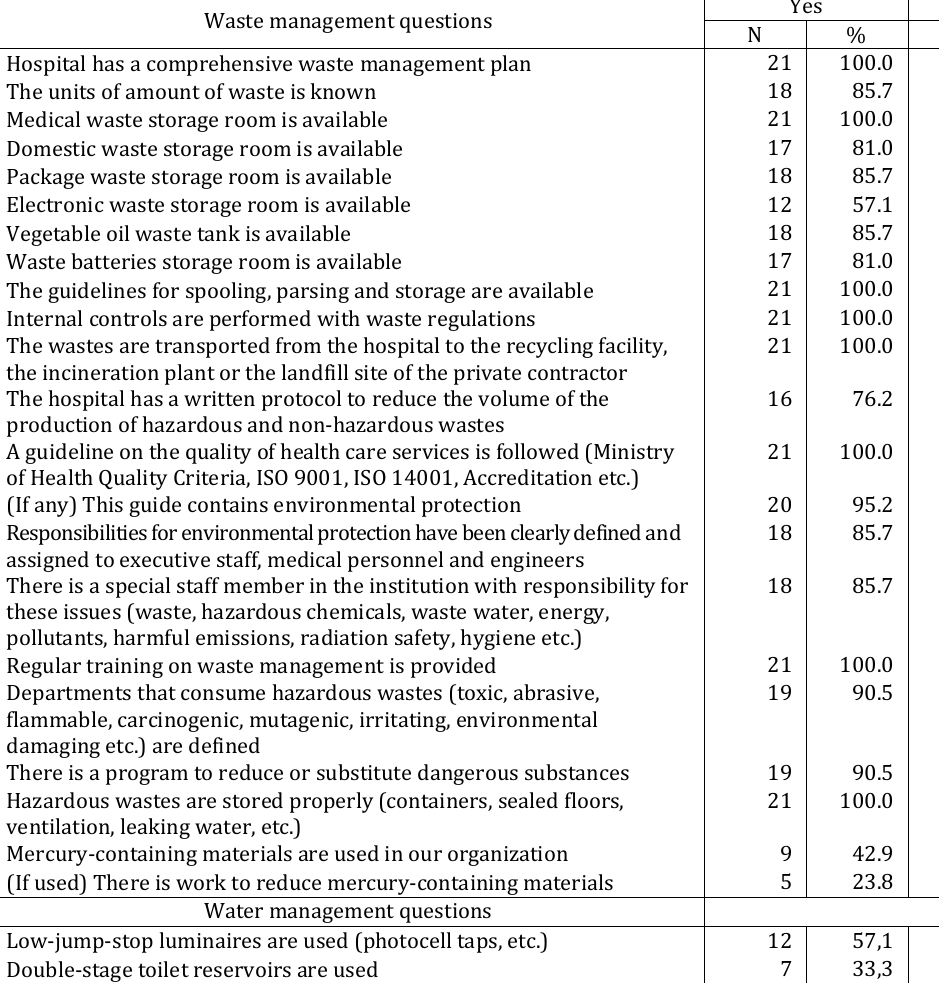
Table 5. Percentage responses to the questionnaire for